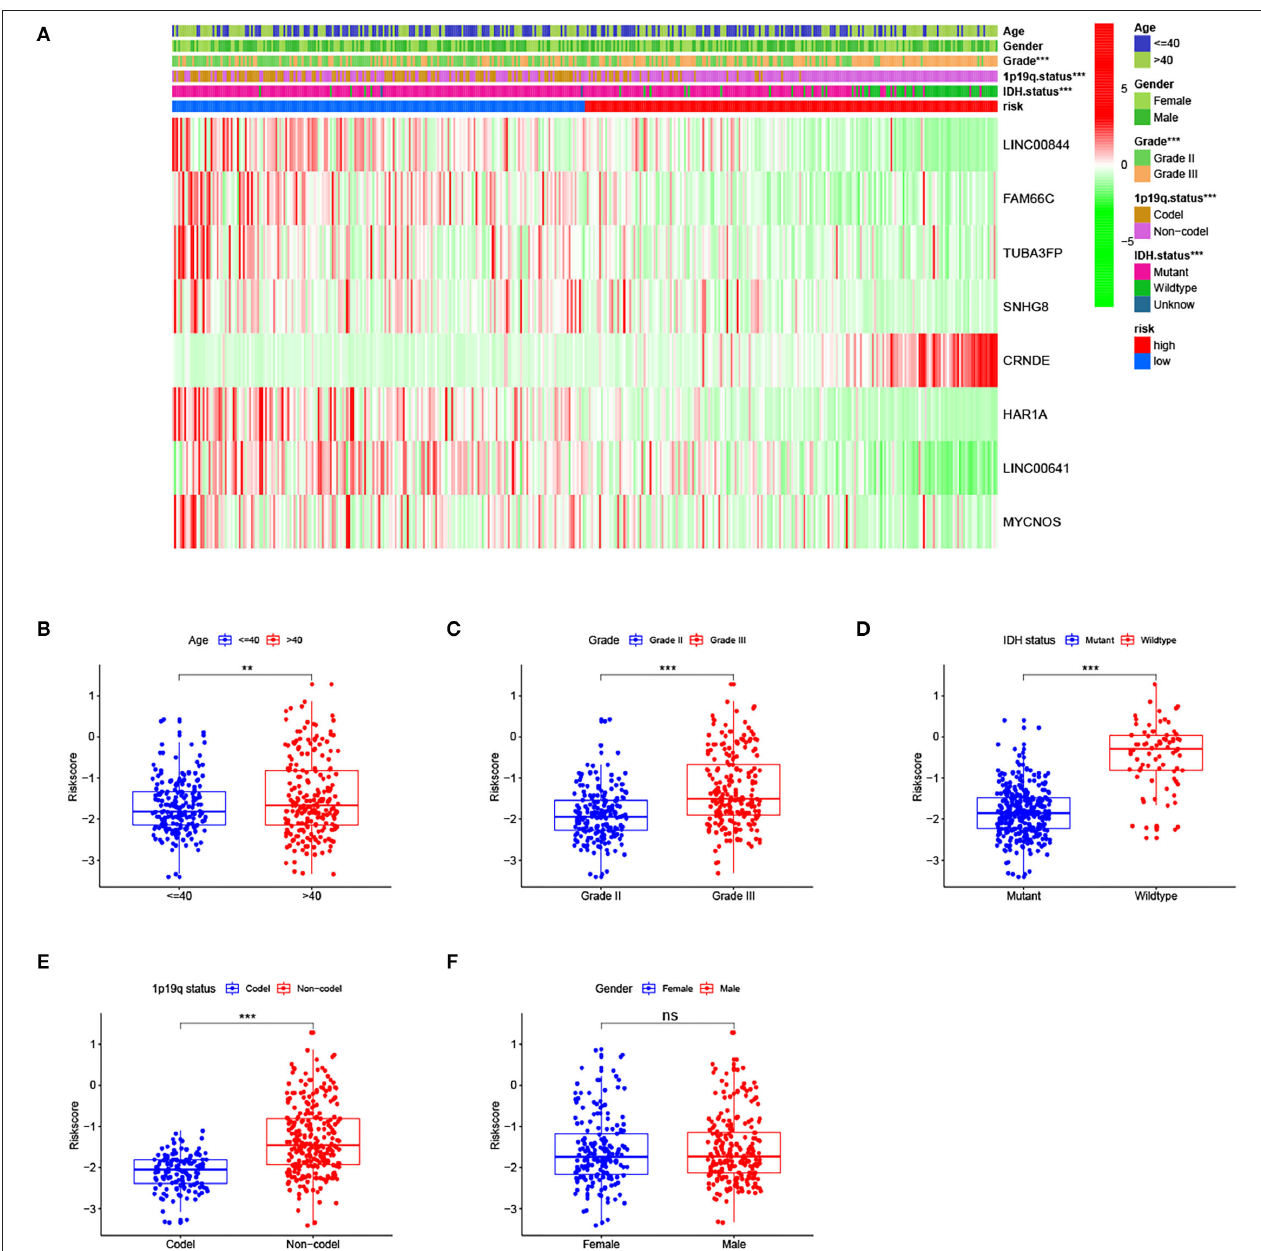
FIGURE 4 | Relationship of the risk signature with clinical characteristics of lower-grade glioma (LGG) in The Cancer Genome Atlas (TCGA) cohort. (A) Heatmap for risk score, selected long noncoding RNAs (lncRNAs), and clinicopathological features. (B–E) LGG patients with age > 40, grade III, isocitrate dehydrogenase (IDH) wild-type, and 1p19q non-codeletion had higher risk scores, and (F) there was no difference between men and women. ** p < 0.01, *** p < 0.001, ns, no significance.